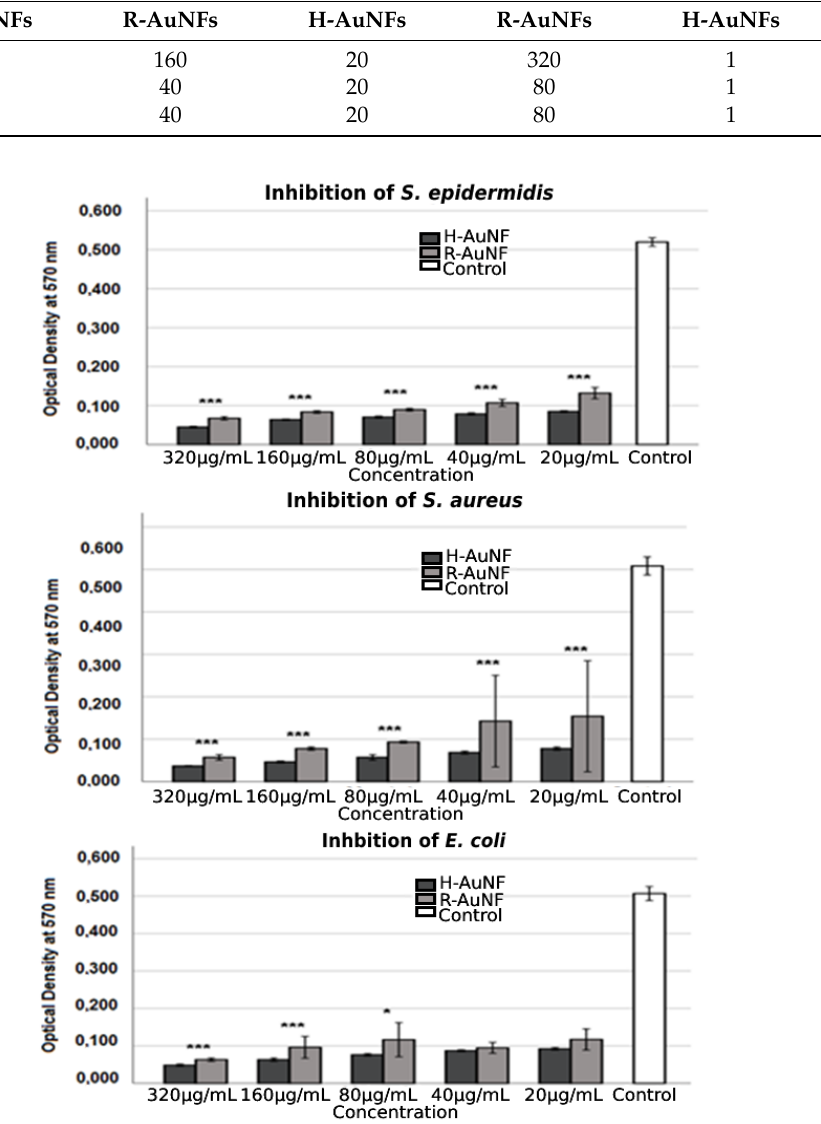
Figure 7. Antibacterial activity of synthesized AuNFs against selected bacteria strains at different